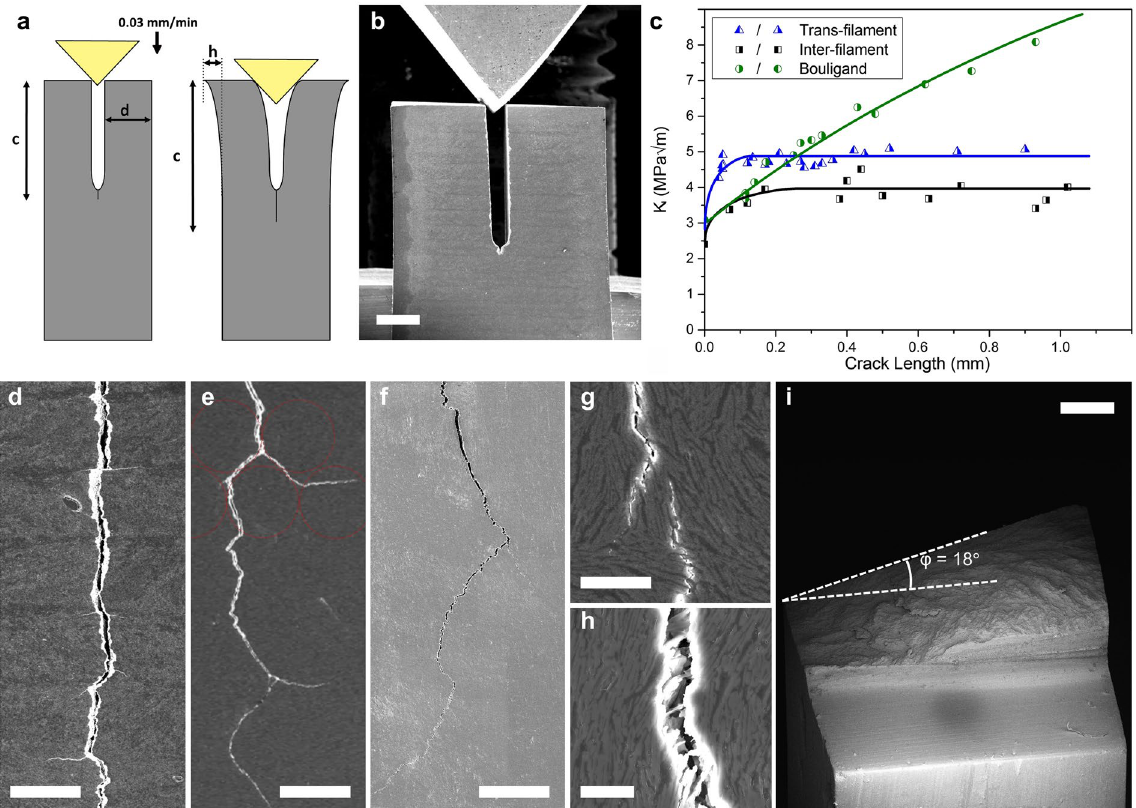
Figure 3. In-situ double cantilever beam testing of bioinspired platelet-epoxy composites. ( a , b ) Diagram and SEM image of the in-situ DCB setup. Scale bar 1mm. ( c ) Crack resistance curves of each composite, plotted from 6 tests. SEM images showing: ( d ) delamination of layers during trans-filament fracture, scale bar 300 μ m, ( e ) deflection around filaments during inter-filament fracture, scale bar 300 μ m, ( f ) crack deflection in the Bouligand structure, scale bar 300 μ m, ( g ) large scale bridging, scale bar 20 μ m, ( h ) small scale bridging of individual platelets, scale bar 10 μ m, ( i ) SEM fractography of the Bouligand material showing a twist of the crack plane, scale bar 0.5